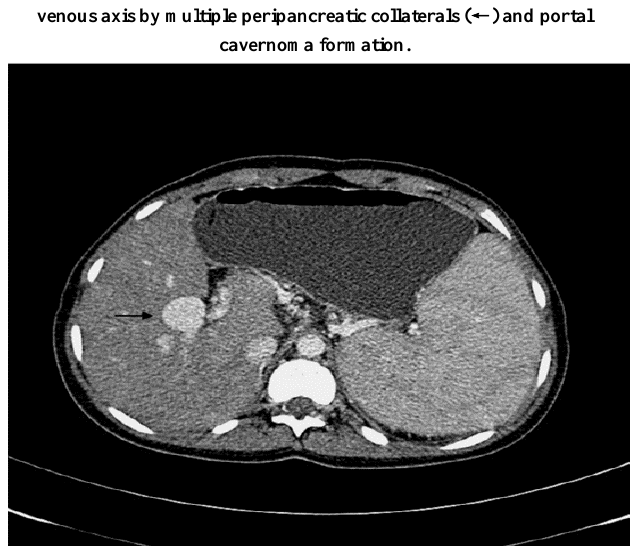
Fig. 3. Axial CT portal venogram image shows a venous aneurysm at portal bifurcation.